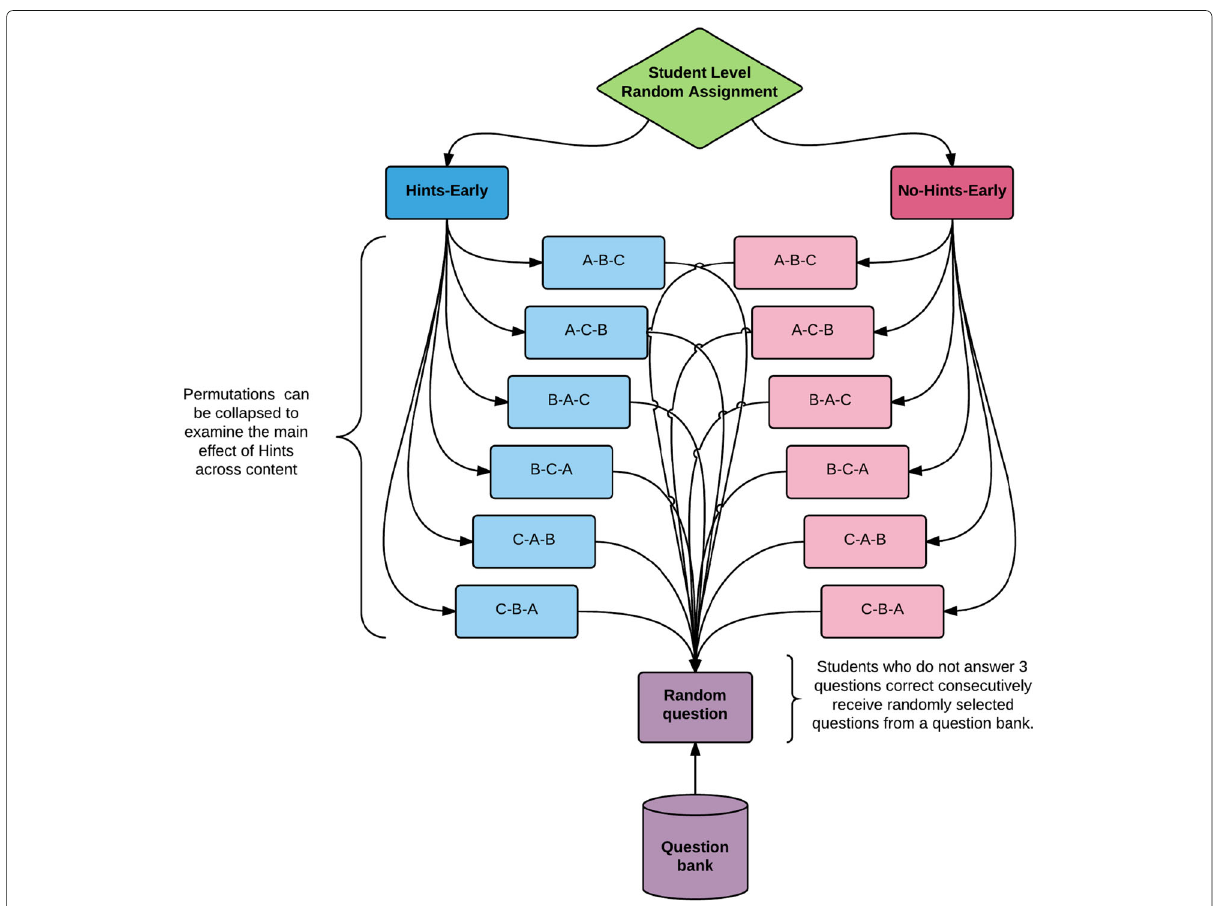
Fig. 3 RCT methodology. Research methodology depicted as a flow chart (Inventado et al. 2016)